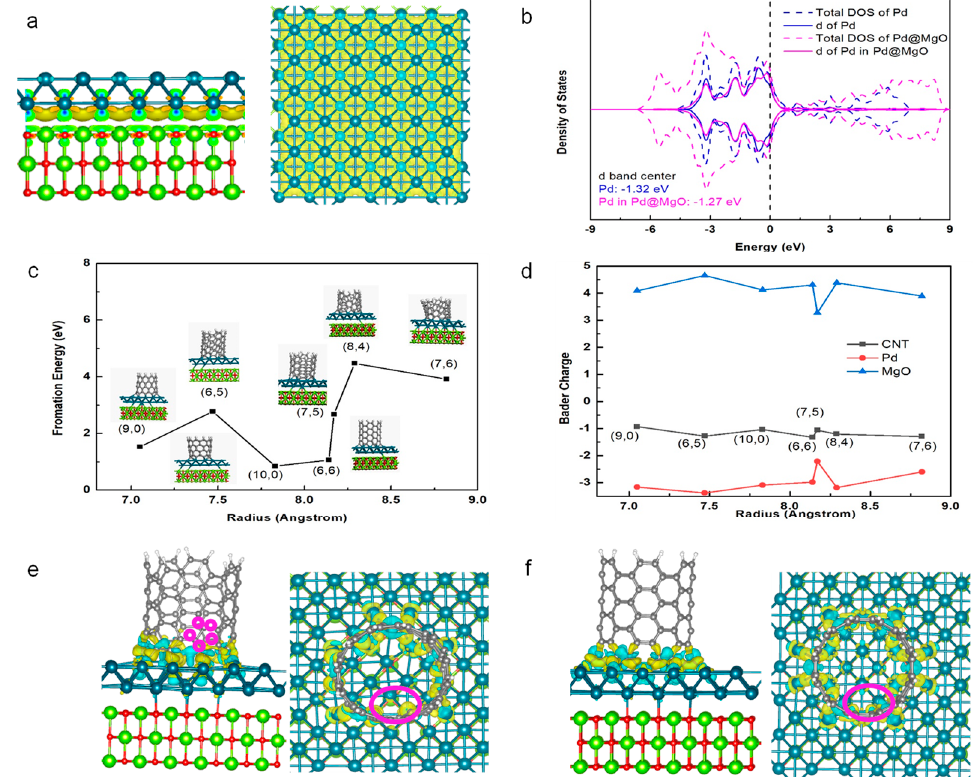
Figure 1. ( a ) The charge density difference for Pd@MgO. ( b ) The density of states (DOSs) of total and Pd d electron in Pd@MgO and Pd(100), as well as the d -band center. ( c ) The interfacial formation energy as the function of SWNT diameter. ( d ) The Bader charge on SWNT, MgO, and Pd. ( e , f ) The charge density difference between (7, 5), (6, 6) SWNT, and Pd@MgO surface, which suggests a perfect structure match and charge transfer. Isovalue = 0.005 a.u. The charge accumulation and depletion are colored respectively in yellow and cyan. Gray balls: C atoms; red balls: O atoms; green balls: Mg atoms; dark green balls: Pd atoms; white balls: H atoms. The small purple circles highlight the formed five-membered ring in (7, 5) SWNT adsorbed on Pd@MgO. The purple ellipses highlight the different charge densities induced by the five-membered ring and six-membered ring.